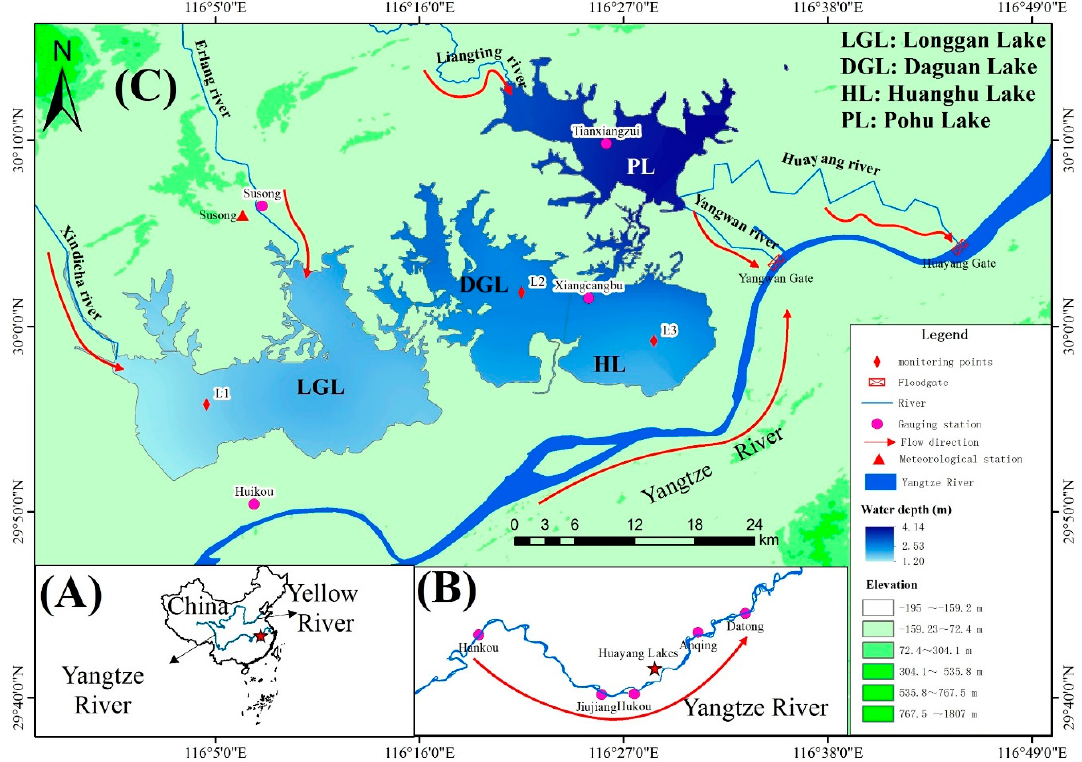
Figure 1. Map of the study region of the Huayang Lakes Basin: ( A ) Location of the Huayang Lakes Basin in relation to the Yangtze River; ( B ) Location of gauging stations in the Yangtze River; and ( C ) the Huayang Lakes Basin and hydrologic/meteorological stations used in this study.